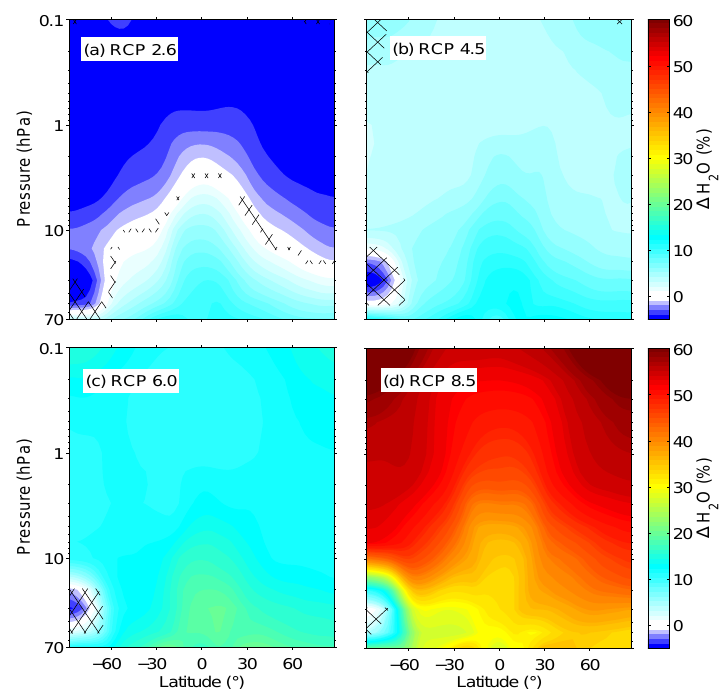
Figure 10. Change in water vapour between the 2000s and 2090s (2090s minus 2000s). Hatching indicates that the difference is not statisti- cally significant at the 95% level of confidence, calculated with Student’s t